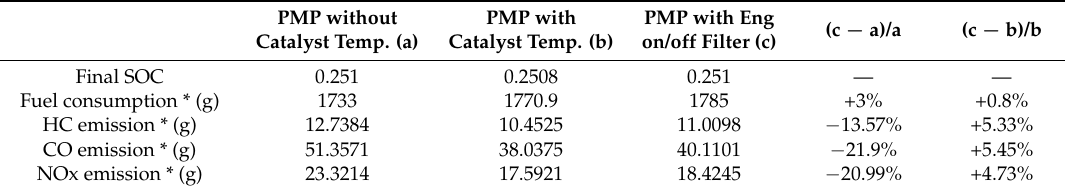
Table 6. Vehicle’s fuel consumption and tailpipe emissions under different EMSs for eight repeated NEDC cycles. PMP without PMP with PMP with Eng (c − a)/a (c − b)/b Catalyst Temp. (a) Catalyst Temp. (b) on/off Filter (c) Final SOC 0.251 0.2508